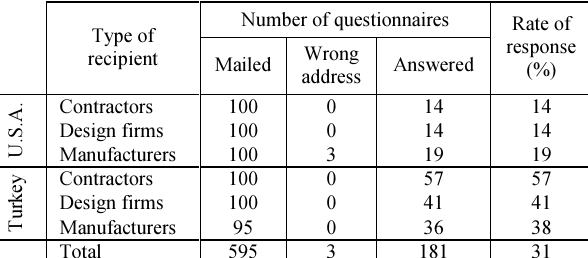
Table 1. Response Rates of Surveys Number of questionnaires Type